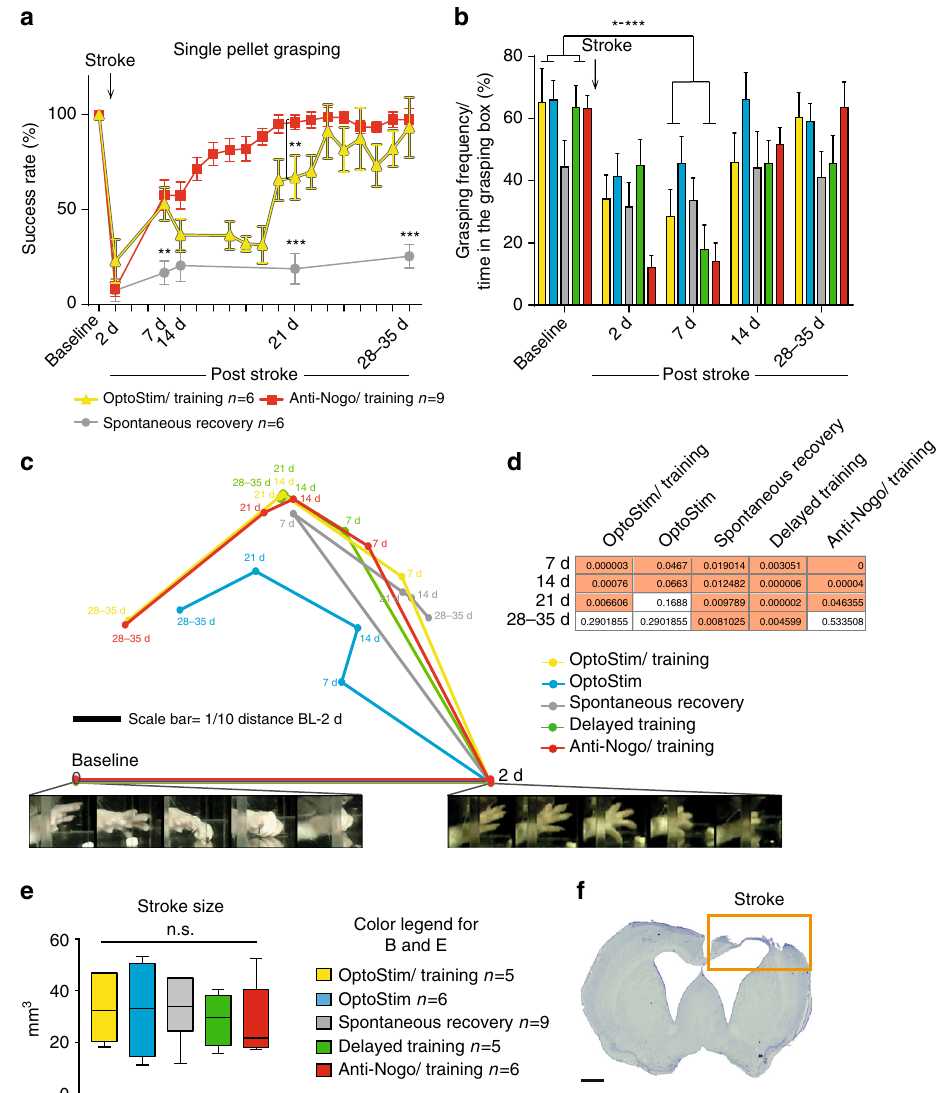
Fig. 2 Brief daily optogenetic stimulation of the intact corticospinal tract leads to full recovery of forelimb function similar to a growth-promoting therapy combined with training. a Stroke animals that received anti-Nogo-A immunotherapy (Anti-Nogo/Training) or optogenetic CST stimulation (OptoStim/ Training group) followed by rehabilitative training performed signi fi cantly better in the single pellet grasping task than stroke animals without treatment (Spontaneous recovery group, same group as in Fig. 1) even 1 week after stroke. b Computer vision-based automatic analysis of overall grasping activity of animals from all fi ve treatment groups (from Figs. 1 and 2a) during their time in the grasping box showed that all animals were less likely to perform single pellet grasping within the fi rst week after stroke, but the frequency of grasping activity was back close to baseline levels in all groups 4 – 6 weeks after stroke. c Automatic video-based grasping analysis. Paws were tracked and represented by comparing them against a codebook of prototypical postures. Thereafter, the similarity of grasping sequences to baseline and 2d grasps was computed using a sequence matching approach and averaged for each recording session of each cohort. The resulting two distances (capturing the relative degradation compared to baseline and the improvement compared to 2d) yield a relative location that is then visualized by triangulation. During the recovery phase, the grasping behavior of the “ Stimulation/Training ” and “ Anti-Nogo/Training ” groups becomes progressively more similar to the baseline con fi guration. In contrast, the delayed training and spontaneous cohorts show no substantial improvement. d Statistical signi fi cance analysis of c . Grasps at 7d, 14d, 21d and 28 – 35 are compared to the baseline. A K – S test then reveals that the “ Spontaneous recovery ” and “ Delayed Training ” cohorts show indeed no signi fi cant recovery ( p > 0.05) at the rehabilitative end point (28 – 35d post stroke), as opposed to the three other treatment cohorts, whose behavior shows no signi fi cant difference compared to baseline anymore. e No signi fi cant difference was found for the stroke lesion size among all fi ve treatment groups examined. f Representative coronal section showing the lesioned motor cortex in Nissl staining (8 weeks after stroke, scale bar = 1 mm). Data are presented as means ± s.e.m.; statistical evaluation was carried out with two-way ANOVA ( a , b ) and one-way ANOVA ( e ) repeated measure followed by Bonferroni post hoc; asterisks indicate signi fi cances: * p < 0.05, ** p < 0.01, and *** p <